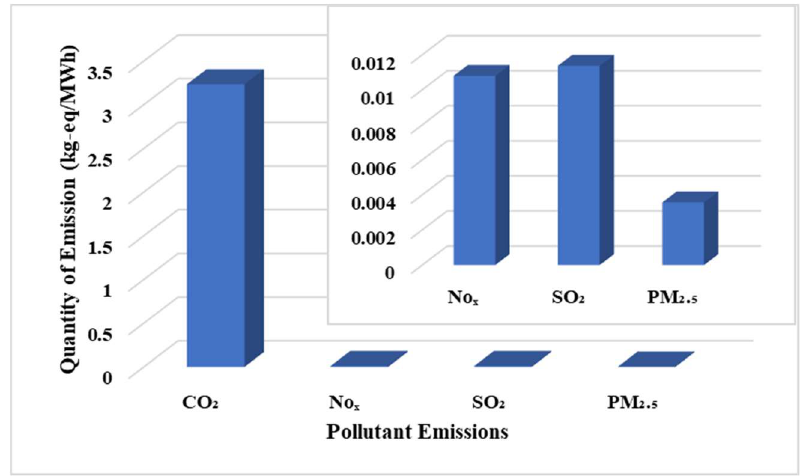
Figure 4. Emissions from landfilling after recycling of the material.